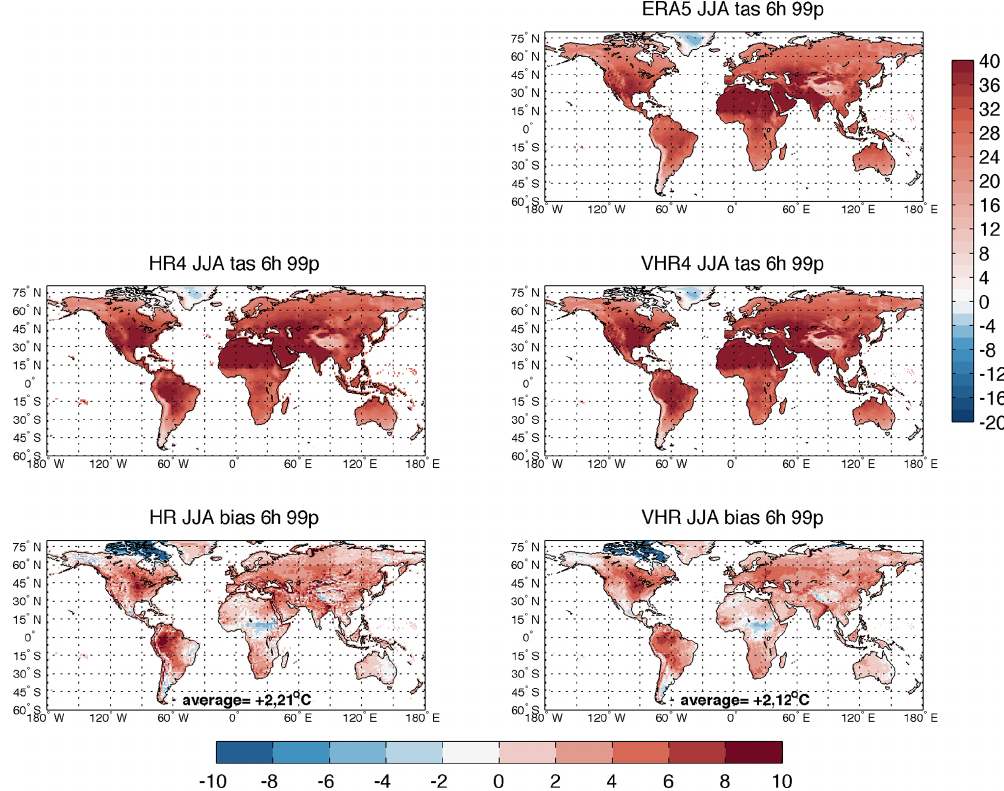
Figure 4. Summer (JJA) extreme temperature (99th percentile, 99p) computed at the 6-hourly frequency. Upper panel shows ERA5 results. Central panels show model results (HR on the left and VHR on the right) and lower panels show the relative model bias. Units are [ ◦ C]. Vertical color bar refers to the three upper panels, while the horizontal color bar refers to the two bottom